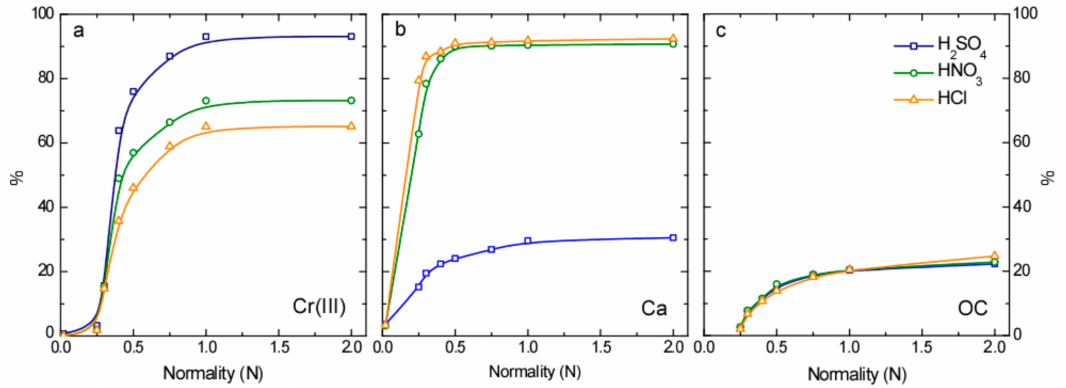
Figure 1. ( a ) Cr(III), ( b ) Ca, and ( c ) organic carbon (OC) leachability from the tannery sludge when using three common inorganic acids; experimental conditions: 20 ◦ C, 60 min, and liquid-to-solid ratio (L / S) equal to 25